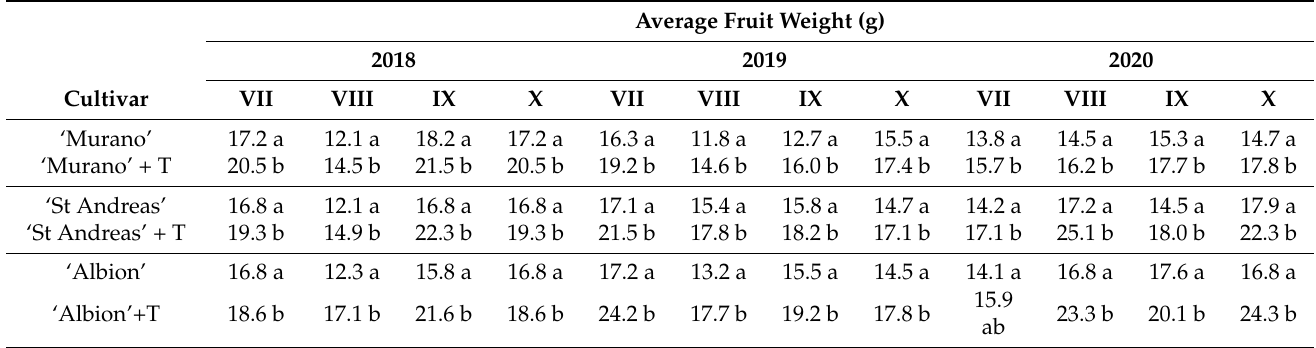
Table 5. The effect of titanium organic complex on average weight of fruit of three strawberry cultivars